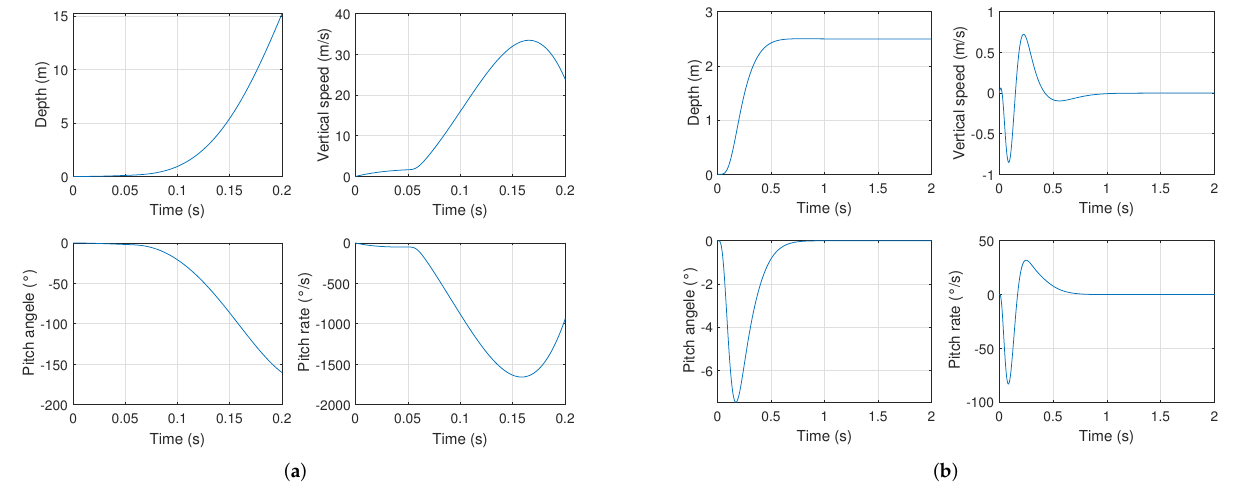
Figure 7. States comparison of the supercavitating vehicle with the DACC and FBL-PPC under the 2.5 m depth command: ( a ) Four states of the SV with the FBL-PPC; ( b ) Four states of the SV with DACC.